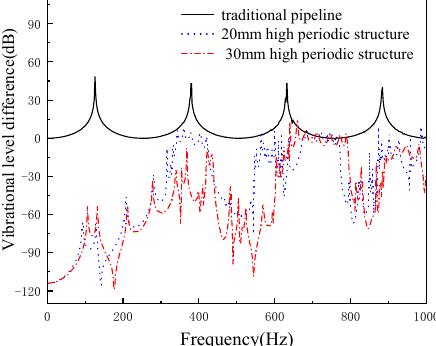
Figure 16. The effects of periodic structure height on cushioning performance (periodic structure